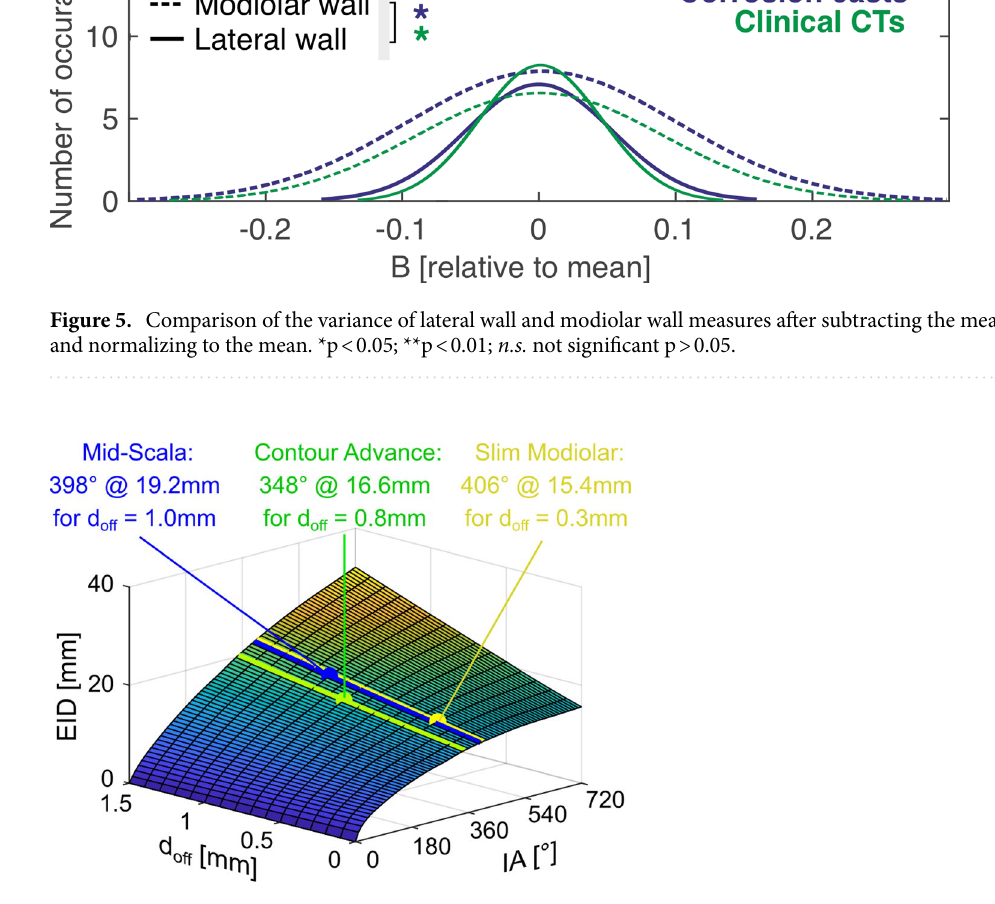
Figure 6. Dependency of the insertion depth (IED) to implantation angle (IA) on the distance from modiolus (d off ) of three different commercial perimodiolar electrode arrays. Data approximated based on an individual corrosion cast reflecting the mean overall size of the human cochlea. For same implantation angle shorter insertion depth is required if the distance to the modiolus is